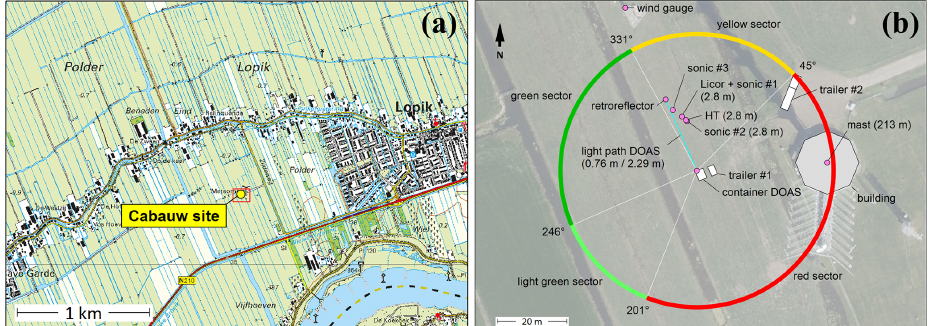
Figure 1. The area surrounding the Cabauw measurement site (a) . Cabauw is in a flat area at − 1m, in the delta of the river Lek shown in the south east. The line with housing going east-west and running north of the site has a series of farms. Map from https://www.pdok.nl/ (downloaded 7 February 2021). The locations of the instruments (b) . The coloured circle denotes wind origin sectors which are used for filtering data (see text). The green and light green sectors indicate wind directions with minimally obstructed flow. Wind from the yellow sector is somewhat obstructed. Wind from the red sector experiences severe obstruction due to the building at the foot of the tall mast, the trailers and the DOAS container. Background aerial photo from https://opendata.beeldmateriaal.nl/ (downloaded 22 February 2022). Data of sonic #3 were not used in the final